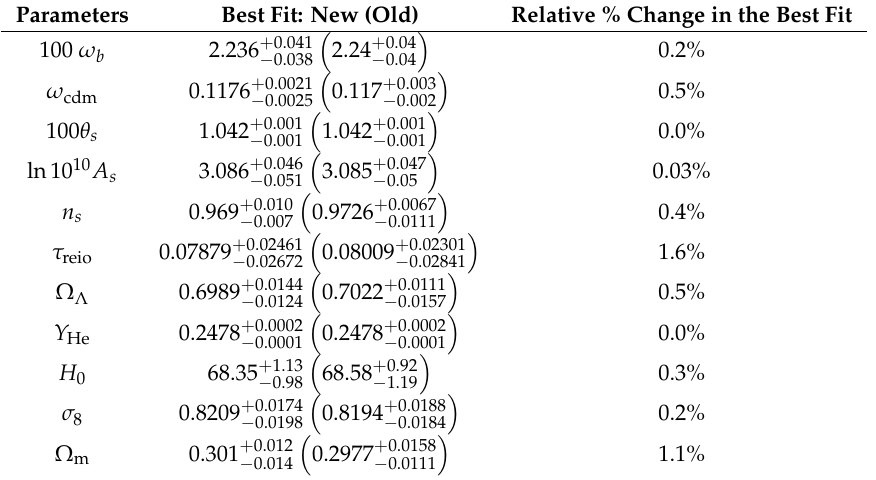
Table 1. Best fit values of cosmological parameters given by MCMC analysis: old vs. new. The upper and lower limits are at the 95% confidence